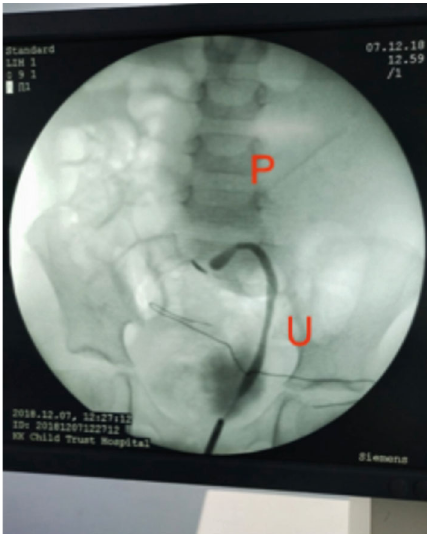
Figure 3: Retrograde study showing left PUJO with diluted contrast in the massive pelvis (P) and contrast in the left ureter.